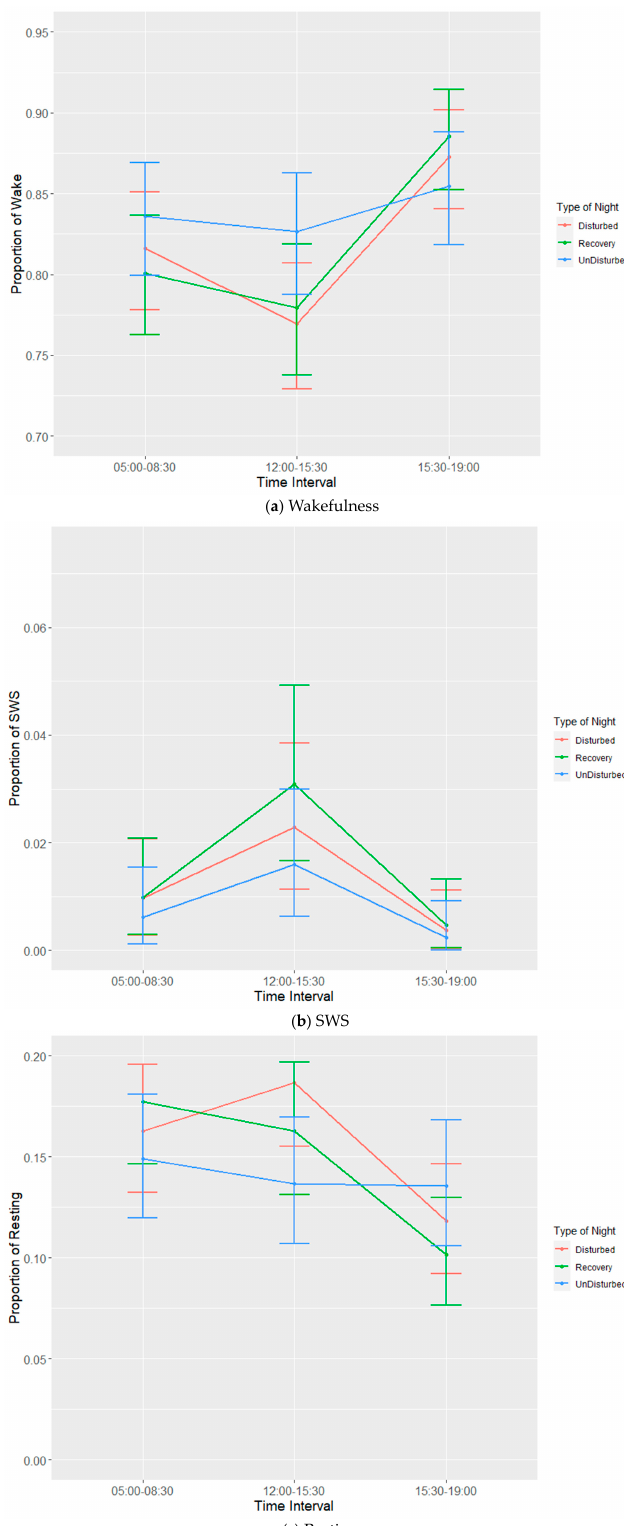
Figure 7. E ff ects during lights on following the three di ff erent types of night on proportions of states (wakefulness (WAKE), slow-wave sleep (SWS) and resting). Values are back-transformed means ± SEs estimated from LMMs fi tt ed to angular transformed proportions.